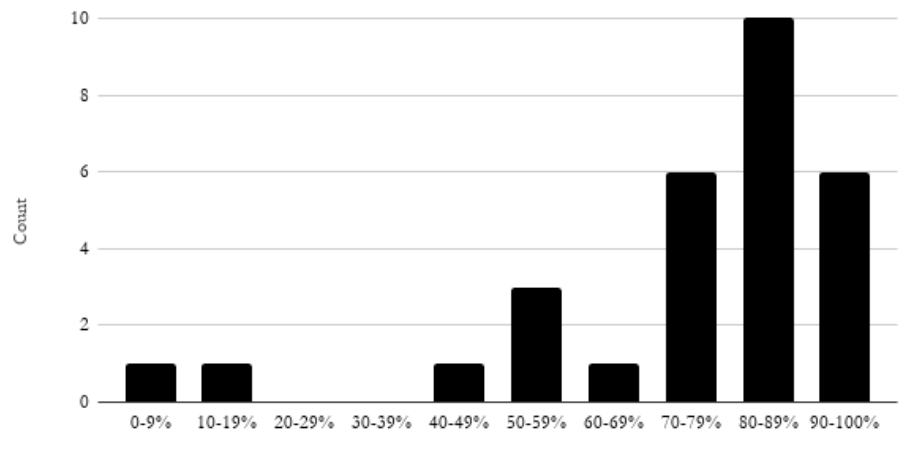
Figure 5. Distribution of textbook-course pairings rated by degree of